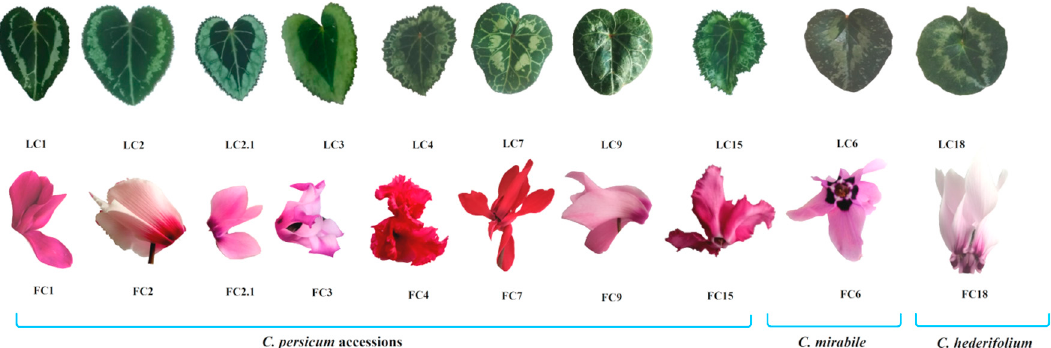
Figure 1. Cyclamen genotypes used in the study (LC—Cyclamen leaves; FC—Cyclamen flowers). C. persicum accessions: C1—Superserie Dark Violet; C2—Victoria; C2.1—Violet fonce; C3—Origami; C4—Merengue Salmon red; C7—Superserie Red; C9—Halios Falbala; C15—Merengue Magenta; C6— C. mirabile ; C18— C. hederifolium .